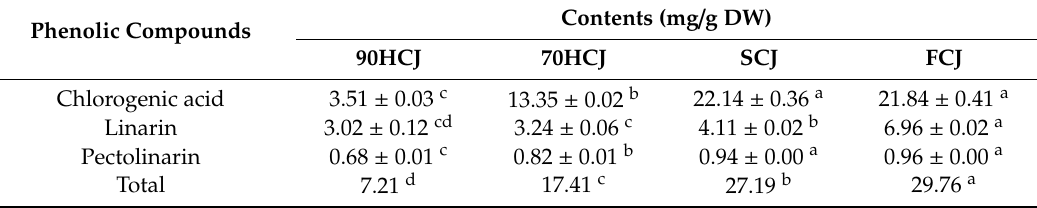
Table 2. Phenolic contents of 90 ◦ C hot-air-, 70 ◦ C hot-air-, shade-, and freeze-dried CJ.